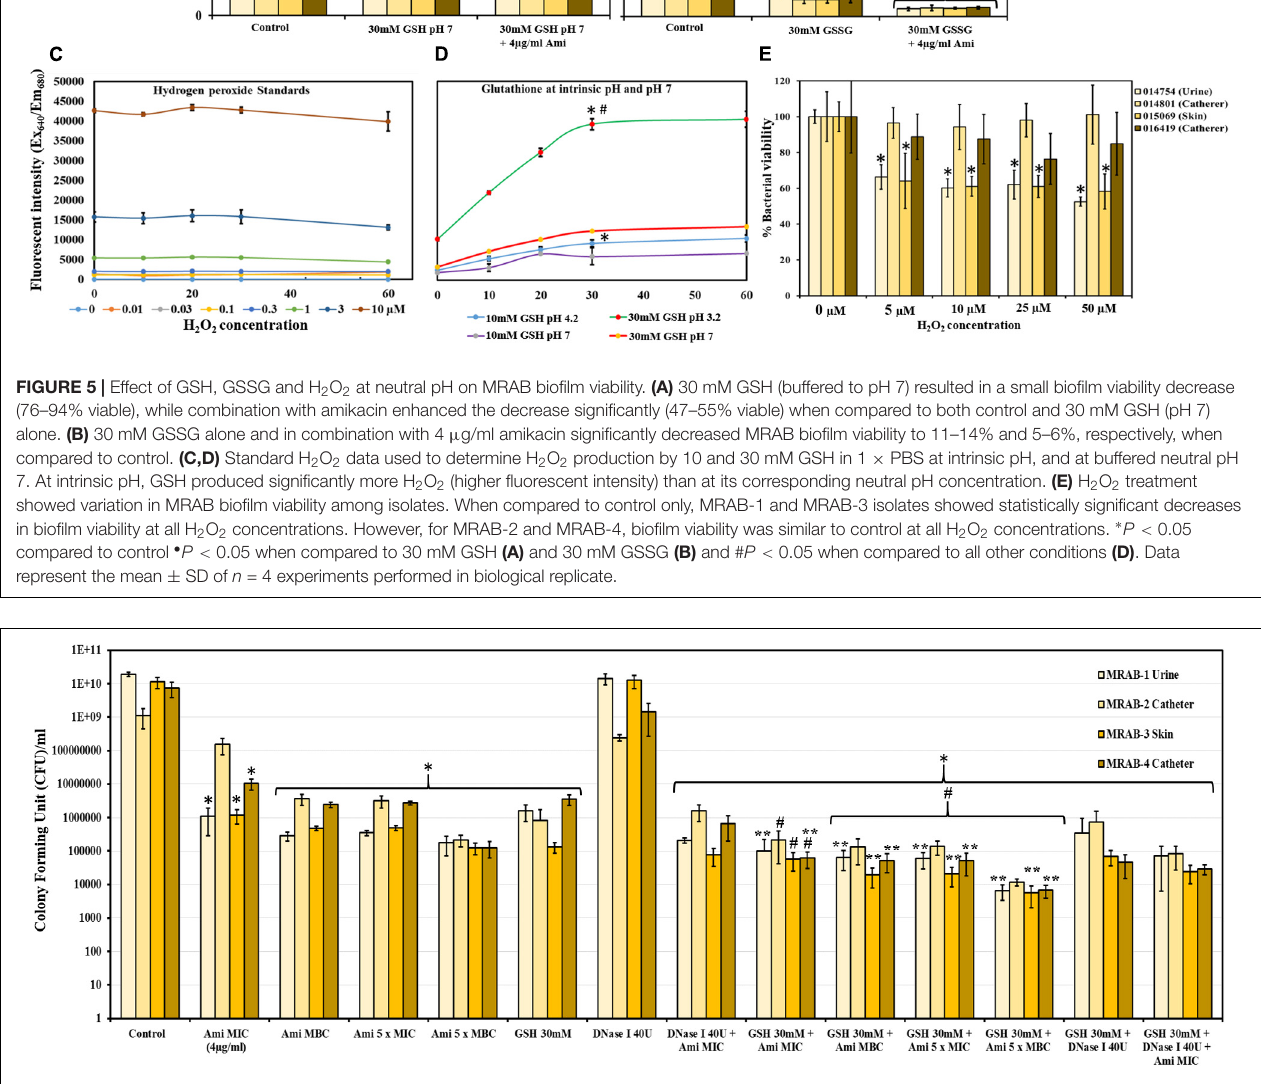
and 4.6–5.9, respectively. GSH (30 mM) + amikacin (MBC) showed the most effective decrease in CFU/ml (1og 10 3.7-4.1). Whereas, triple combination treatment (30 mM GSH + 40U DNase-I + 4 µ g/ml amikacin) resulted in a CFU/ml between